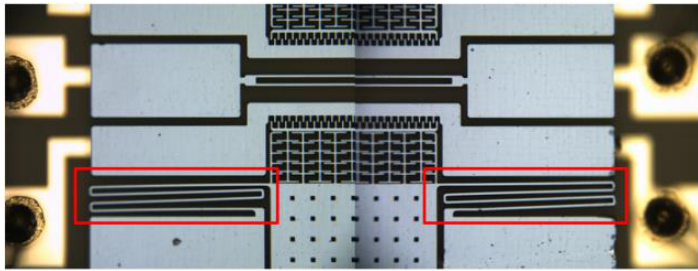
Figure 24. Deformation of double-stage folded beam (zoomed in).